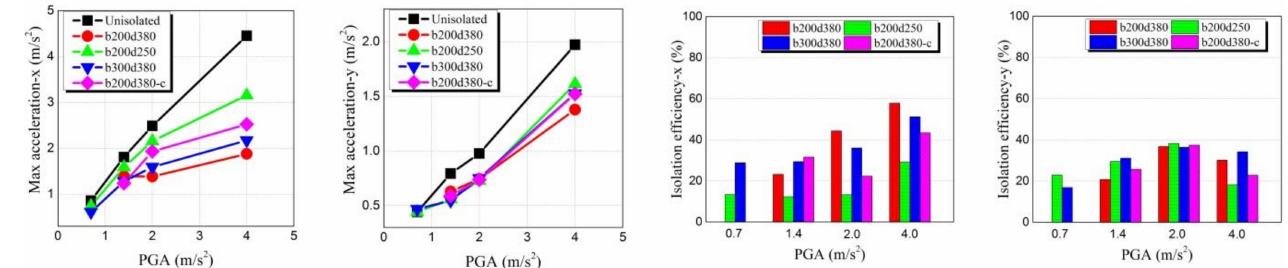
Figure 26. The maximum acceleration responses and isolation efficiency under ChiChi-TCU084 (medium-frequency) ground motion.